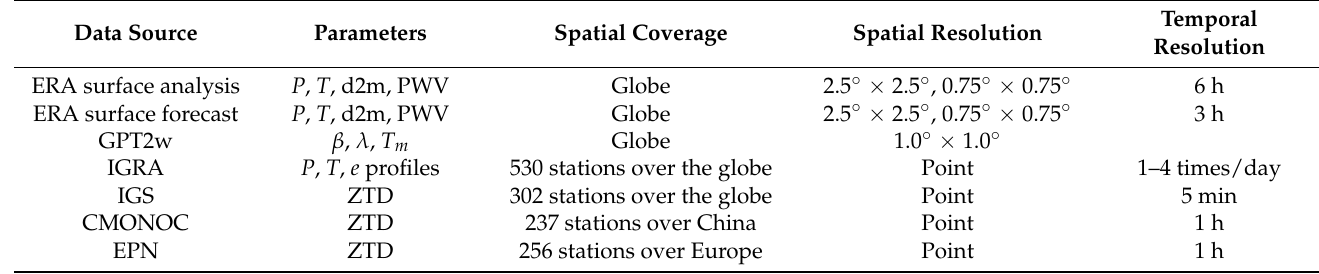
Table 1. Characteristics of the data sources used in this